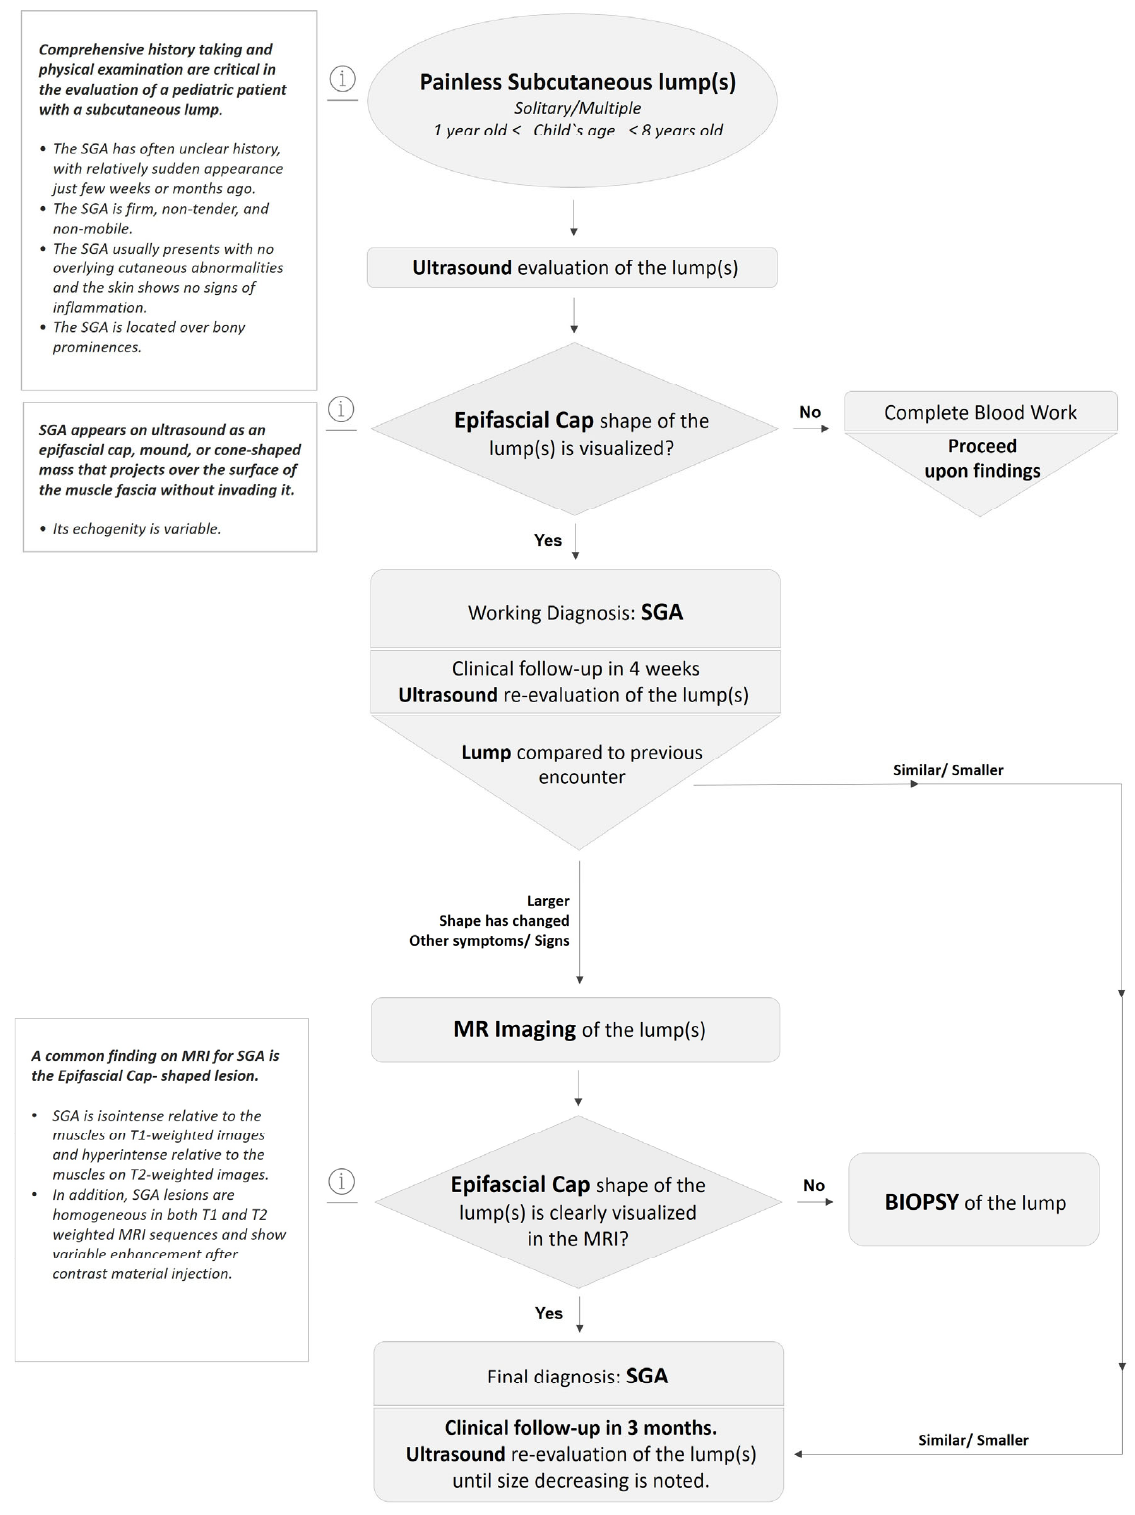
Figure 12. Management algorithm for Subcutaneous Granuloma Annulare in children.